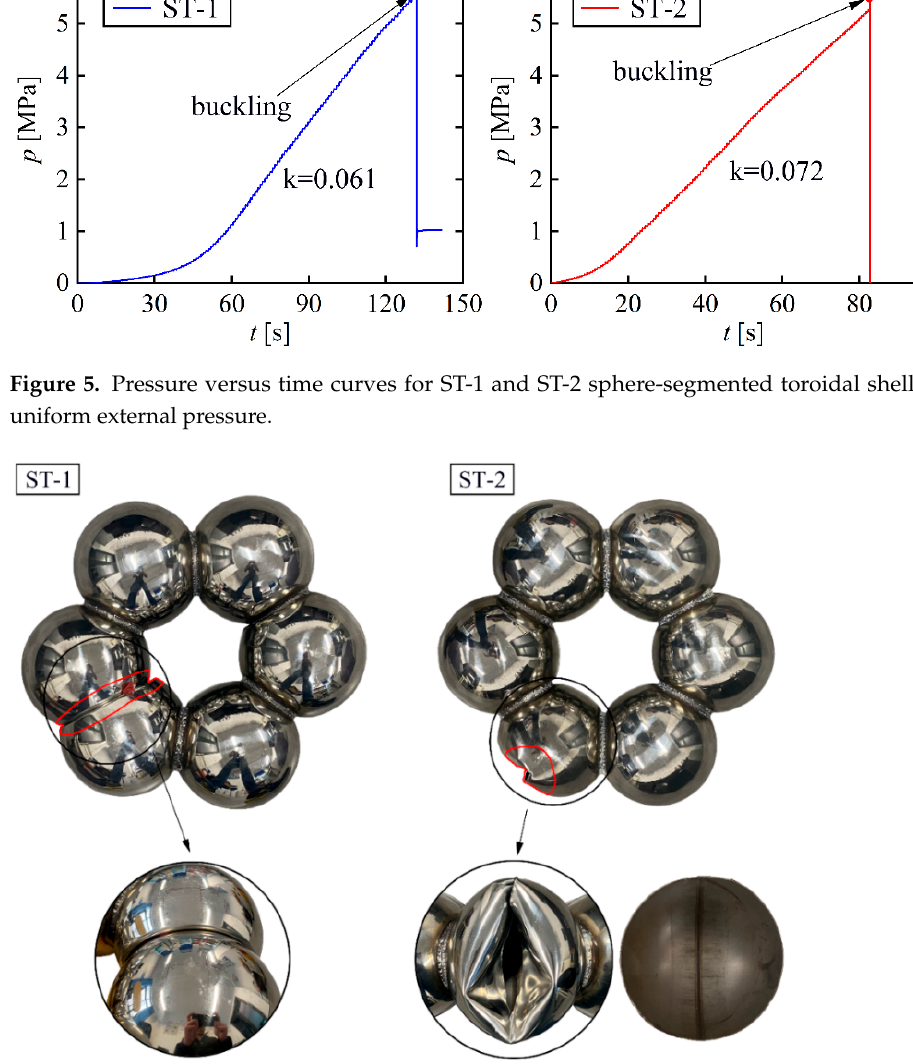
Figure 6. Failed sphere-segmented toroidal shell and collapse locations.